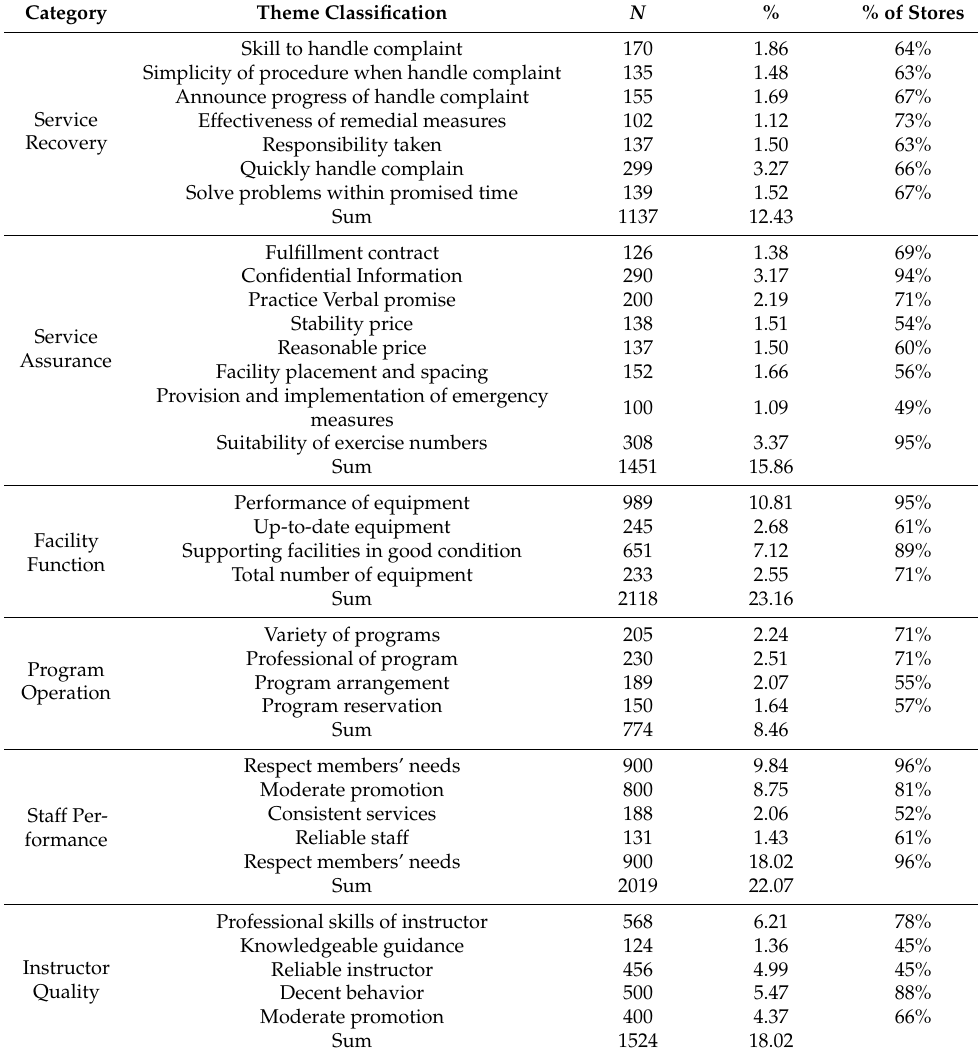
Table 3. Coding Categories and Themes Derived from the Content Analyses (9147